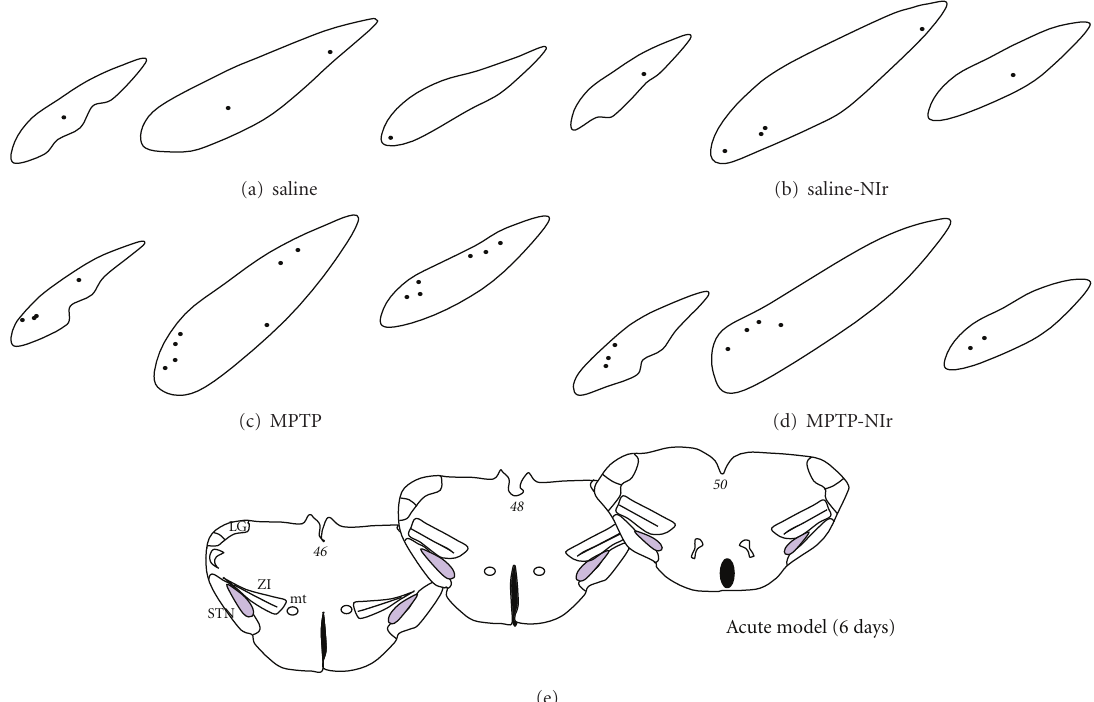
Figure 4: Schematic diagrams of the distribution of Fos + cells in the di ff erent sectors of the STN in the saline (a), saline-NIr (b), MPTP (c) and MPTP-NIr groups. These maps are from the acute model with six-day survival period (similar patterns were evident in the chronic model; in the acute model with two-hour survival period, the distribution of cells was similar to the saline cases shown here). Each black circle represents one cell. These maps were taken from coronal sections similar to the plates of the mouse atlas (numbers in italics [1]) shown in